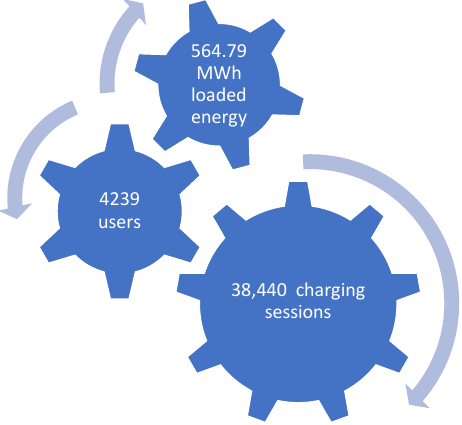
Figure 8. Relevant data concerning the EV charging sessions in Cluj-Napoca between January 2020 and June 2022.